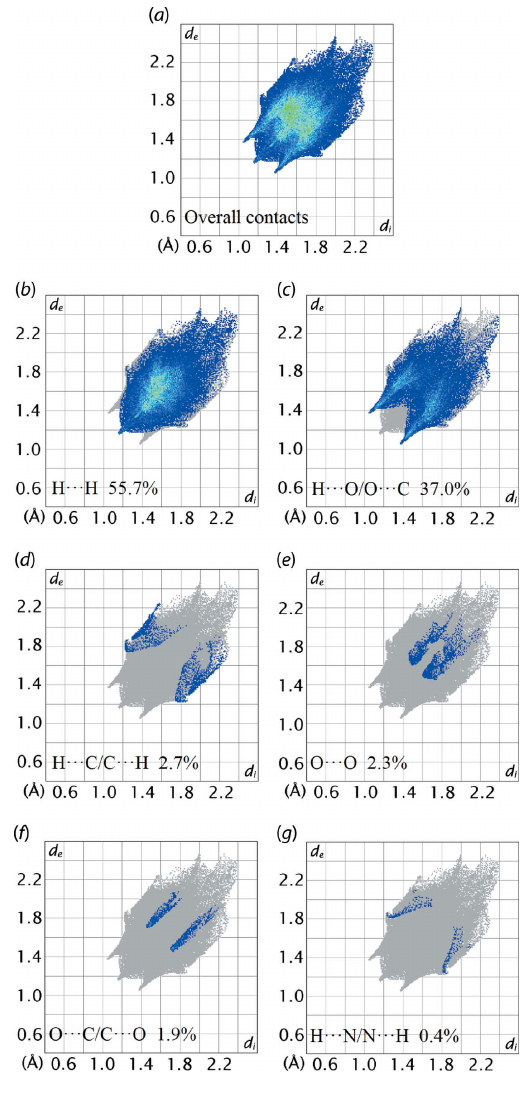
Figure 6 ( a ) The full two-dimensional fingerprint plot for (II) and ( b )–( g ) those delineated into H (cid:3)(cid:3)(cid:3) H, O (cid:3)(cid:3)(cid:3) H/H (cid:3)(cid:3)(cid:3) O, C (cid:3)(cid:3)(cid:3) H/H (cid:3)(cid:3)(cid:3) C, O (cid:3)(cid:3)(cid:3) O, C (cid:3)(cid:3)(cid:3) O/ O (cid:3)(cid:3)(cid:3) C and H (cid:3)(cid:3)(cid:3) N/N (cid:3)(cid:3)(cid:3) H contacts,